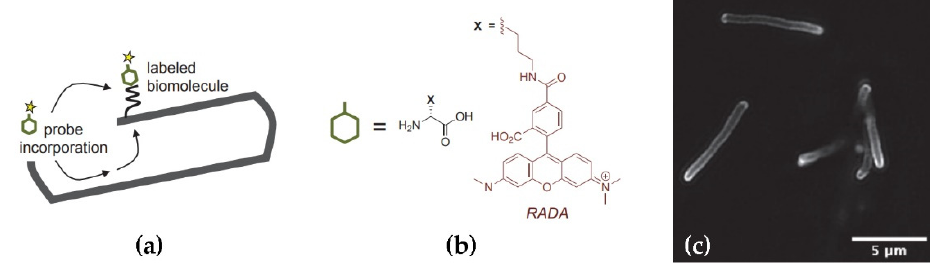
Figure 3. D -aa fluorescent derivatives (e.g., RADA) have been proposed to visualize peptidoglycan biosynthesis. ( a ) Schematic for bacteria metabolic labelling with RADA. ( b ) Chemical structure of RADA. ( c ) Confocal microscopy image of M. smegmatis stained with RADA. Adapted from [49]